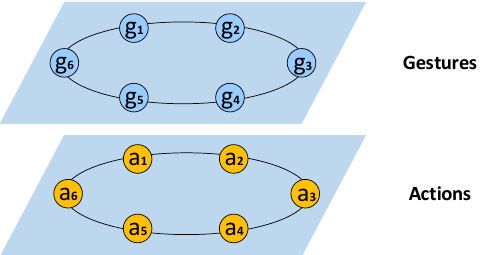
Figure 15. Actions and gestures confusion ring sequence: g 1 : Rock, g 2 : Vertical palm, g 3 : Vertical knife, g 4 : Paper, g 5 : Horizontal palm, g 6 : Horizontal knife. Description for actions: a 1 : Waving left hand, a 2 : Hands up, a 3 : Draw circles in front of chest, a 4 : Swing hand up and down, a 5 : Waving right hand, a 6 : Draw circles over